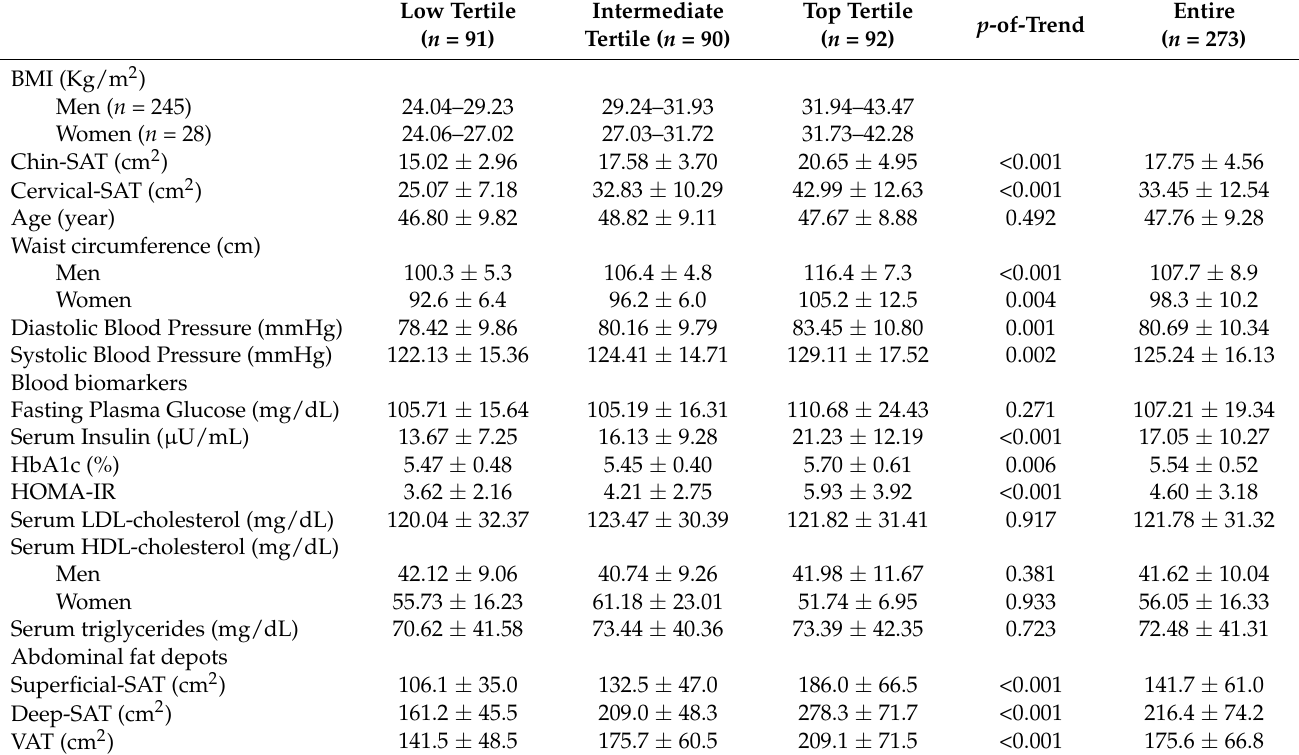
Table 1. Baseline characteristics of the study population across sex-specific tertiles of